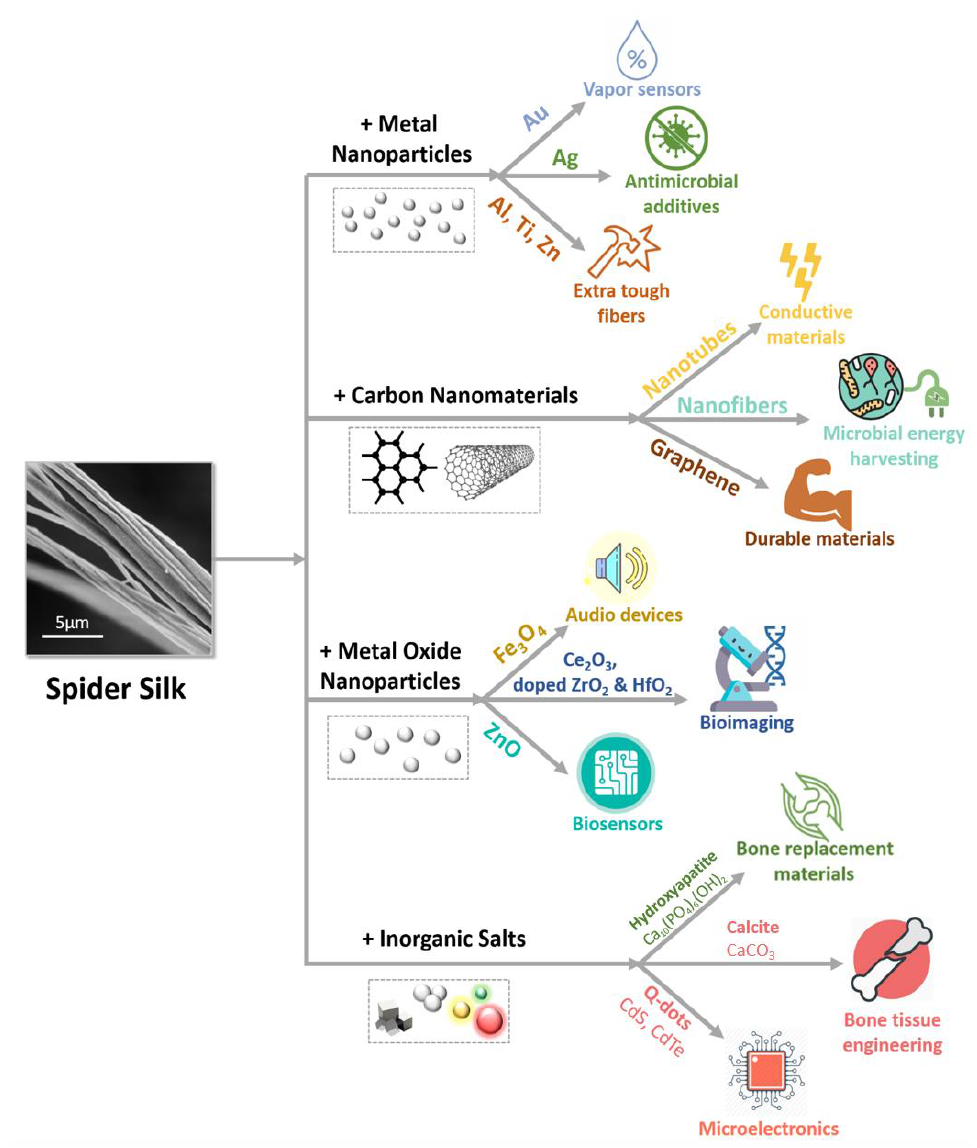
Figure 2. Schematic summary of spider silk modification with inorganic nanomaterials with resulting material material applications.